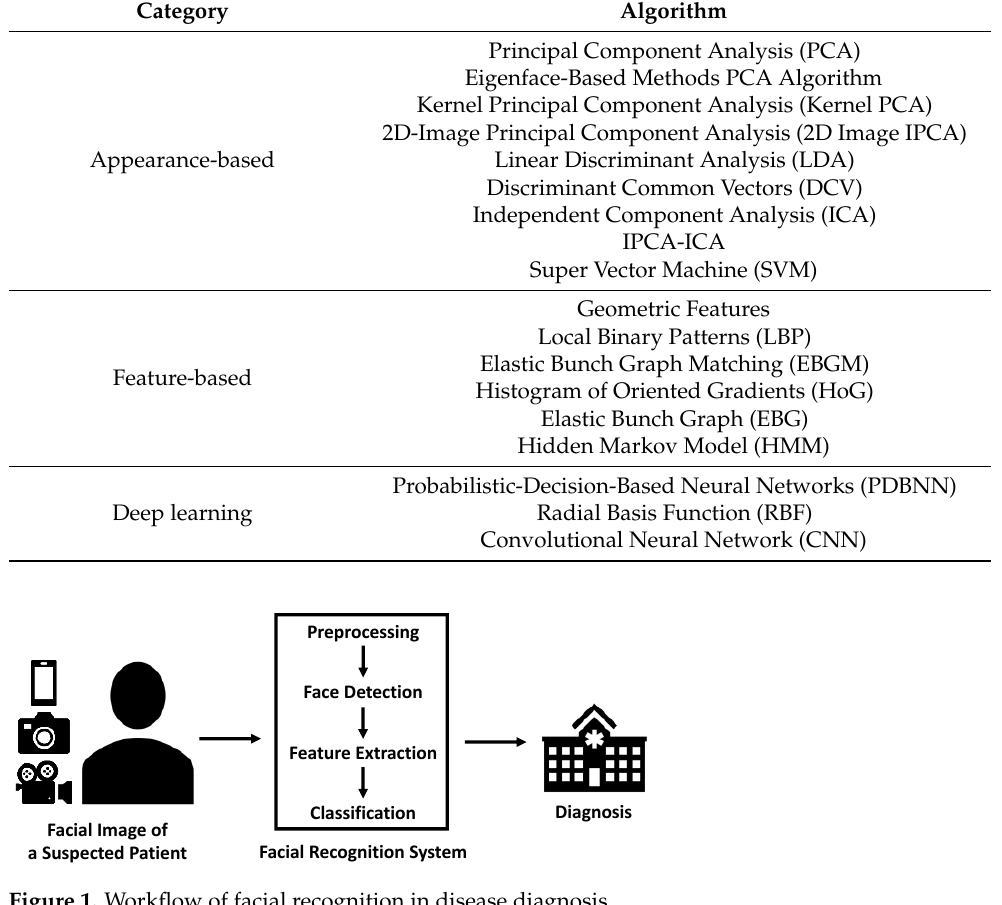
Table 1. Facial Analysis Algorithms.